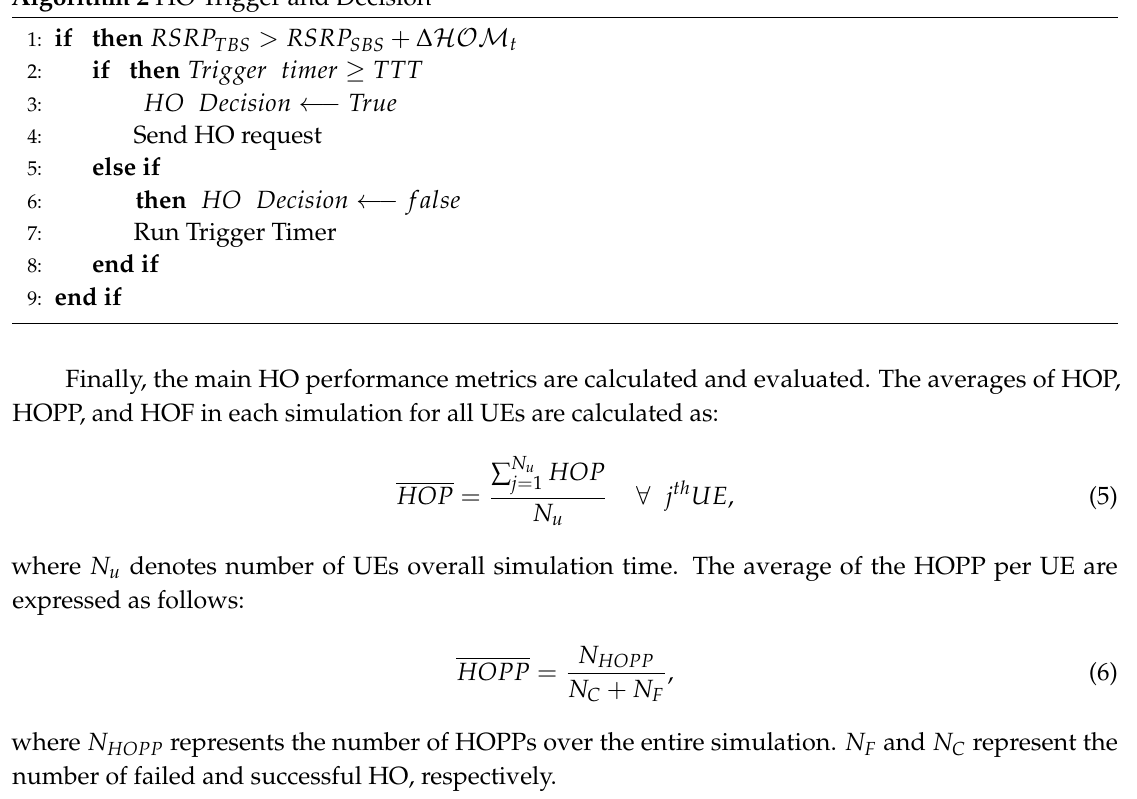
Algorithm 2 HO Trigger and